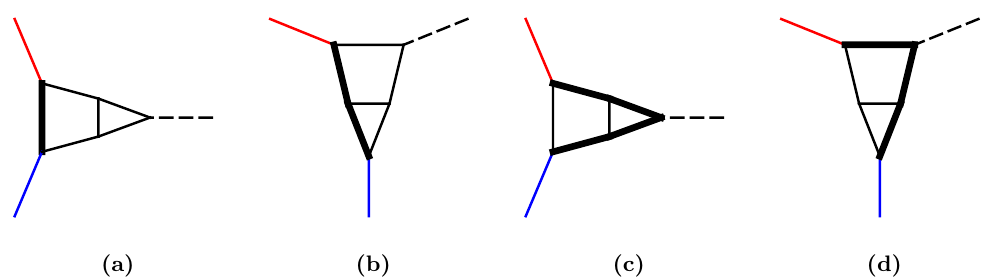
Figure 2. Two-loop topologies for X 0 W + W (cid:0) interactions. Thin lines represent massless propa- gators and thick lines stand for massive ones. The dashed external line corresponds to the o(cid:11)-shell leg with squared momentum equal to s whereas the red and blue lines represent the two external vector bosons with o(cid:11)-shell momenta p 2 and p 2 1 2